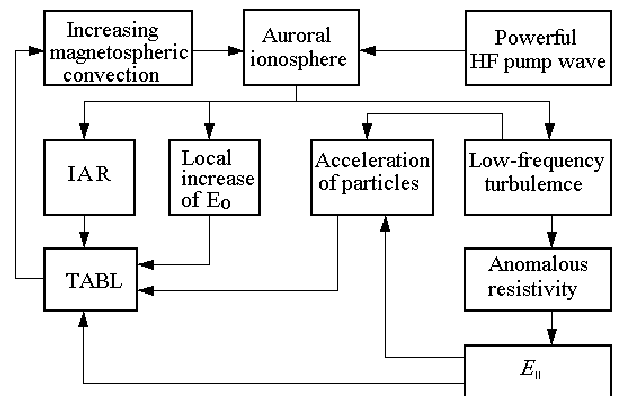
Table 4. Distinctive features related to auroral activations in course of the experiments